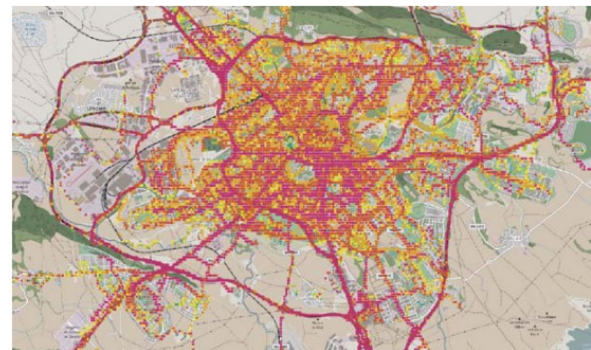
Figure 3. RESPIRA’s map of NO2 concentration on Pamplona (Spain) (40x40m). c (cid:13)